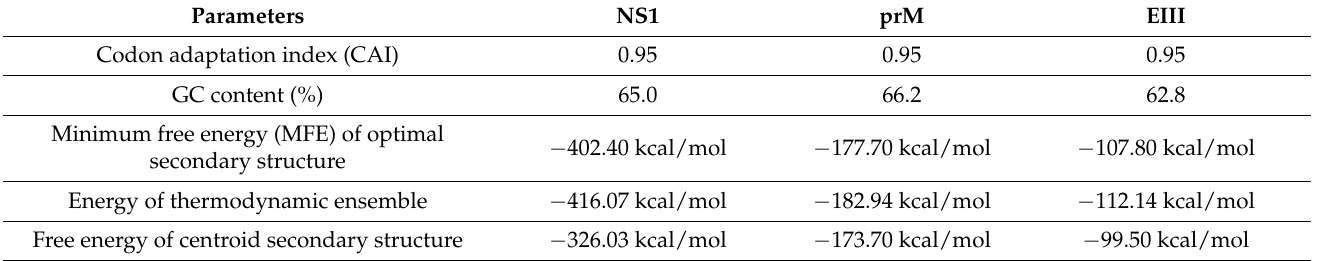
Table 1. Codon optimization of Nucleotides.